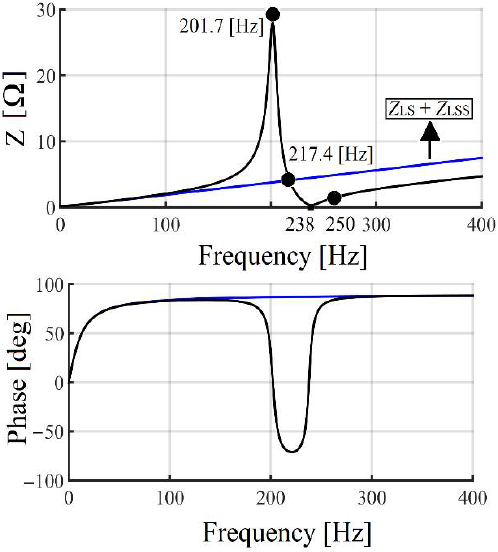
Figure 51. Impedance versus frequency characteristic observed at the load input (from the simulated model).